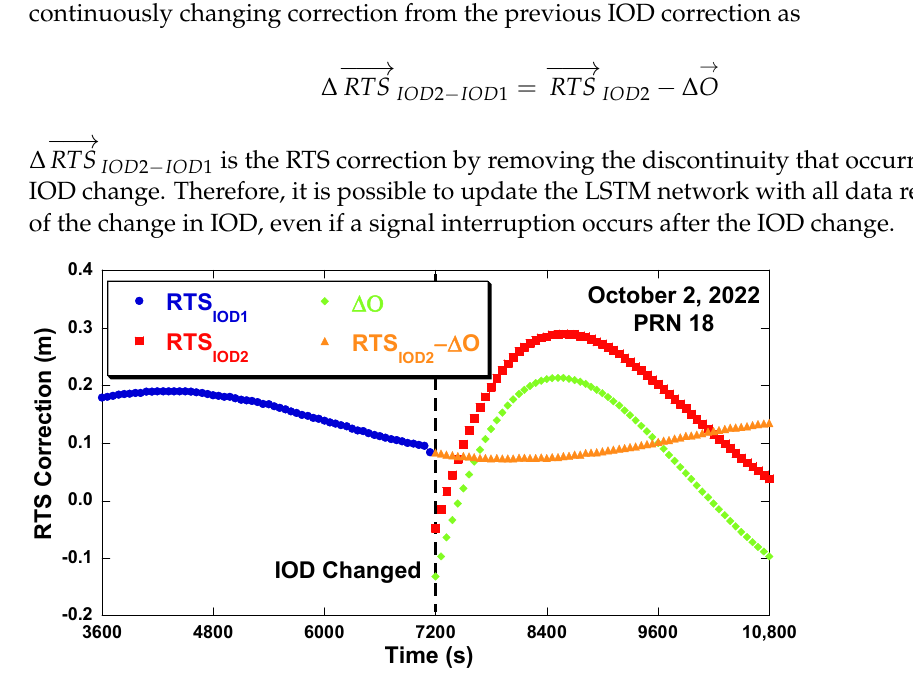
Figure 5. RTS orbit correction and difference at the time of the IOD change (28 September 2022).